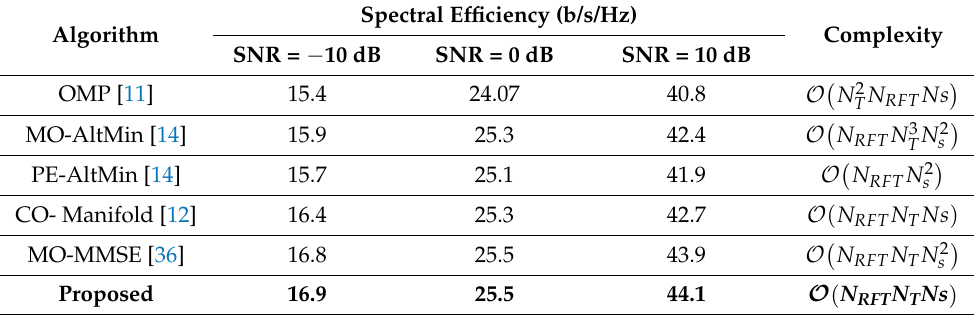
Table 1. Comparison of spectral efficiency and complexity for different algorithms for different values of the SNR.